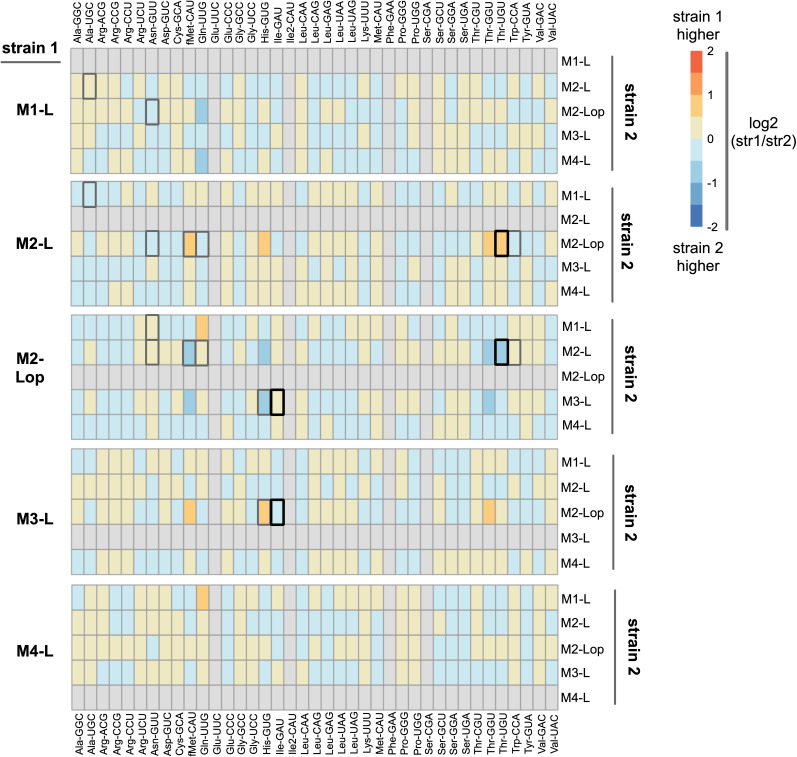
Comparison of expression levels of tRNA types in five strains isolated from mutant lineages on day 13.YAMAT-seq was performed, and data analysed, as described in the manuscript. The read numbers provided in Supplementary file 7 were used for DESeq2 pairwise comparisons between three replicates of each strain (output is in source data file 5). Here, the log2-foldchange of each tRNA type is plotted as a heat map for all 20 pairwise comparisons between the five mutant lineage isolates (e.g., M1-L versus each of M2-L, M2-Lop, M3-L, and M4-L). Orange/red colouration indicates higher expression in strain 1, blue in strain 2 (colour intensity denotes the size of the difference; darker colour = larger difference). Boxes for four tRNA types (Glu-UUC, Ile2-GAU, Phe-GAA, Ser-CGA) are filled in grey; these were removed from the analysis due to very low YAMAT-seq read numbers for both strains (see main manuscript Results). Boxes for tRNA types with statistically significant differences are highlighted by black or dark grey borders (black border DESeq2 p<0.001, dark grey 0.001 < p< 0.01; light grey p>0.01).